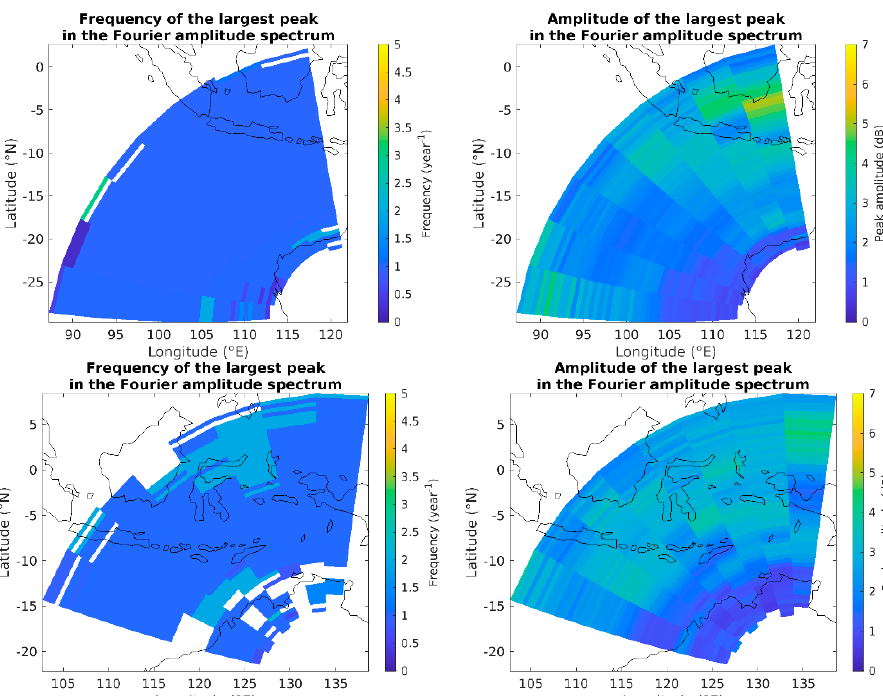
Figure 15. Fourier analysis on the LO, LAE, LAW and AS backscatter coefficients over a decade (listed from top to bottom). ( Left ): The frequency of the largest peak in the Fourier amplitude spectrum (only statistically significant peaks are shown). ( Right ): The amplitude of this largest peak.